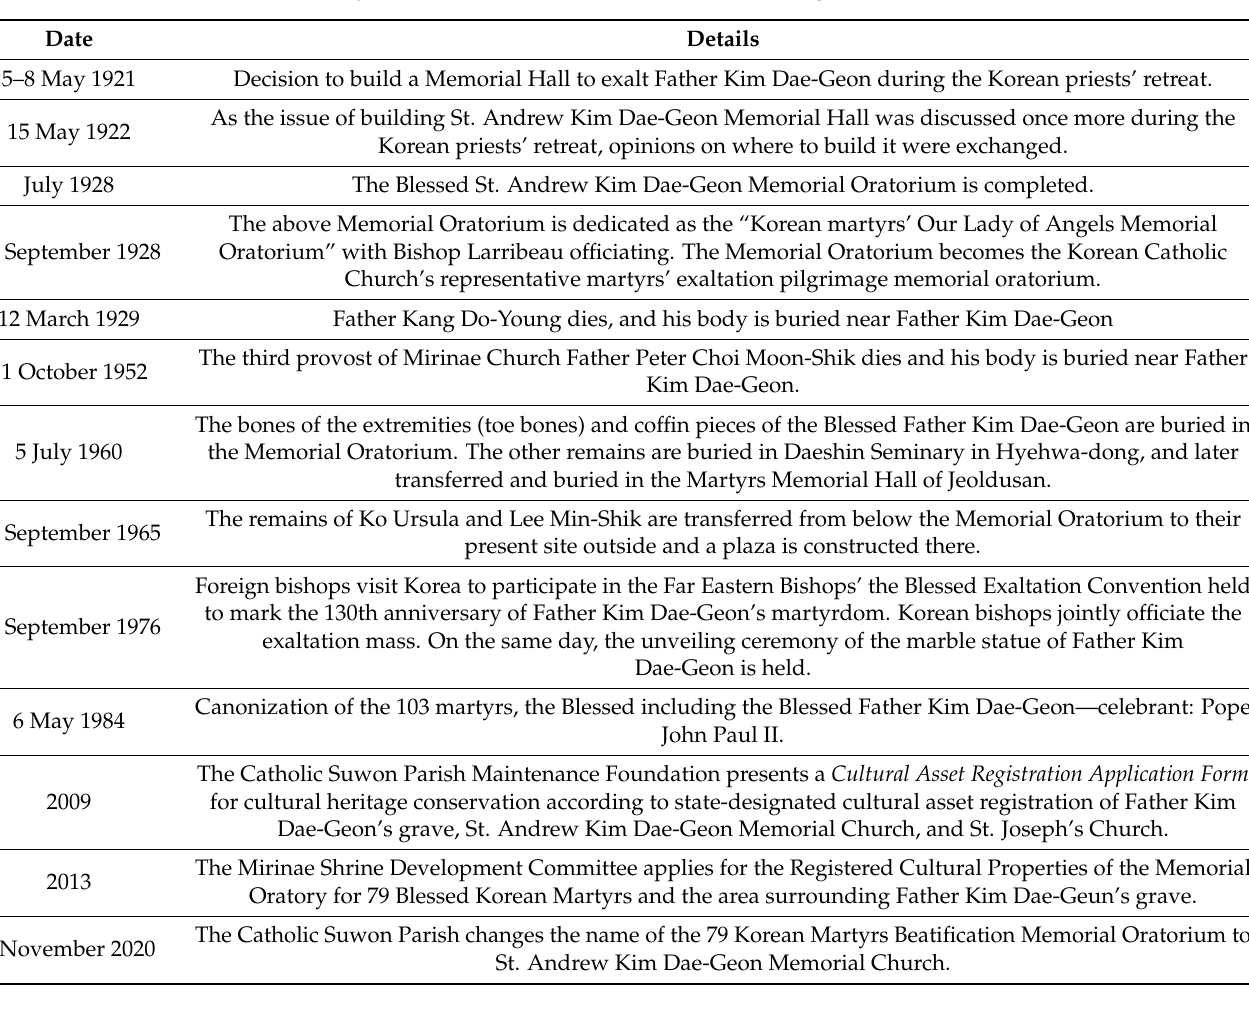
Table 1. History of the Memorial Church and the Surrounding Areas of Graves 13 .